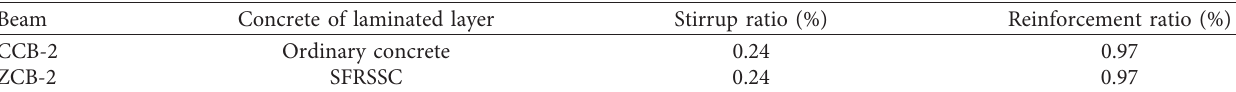
Table 6: Details of two-span continuous